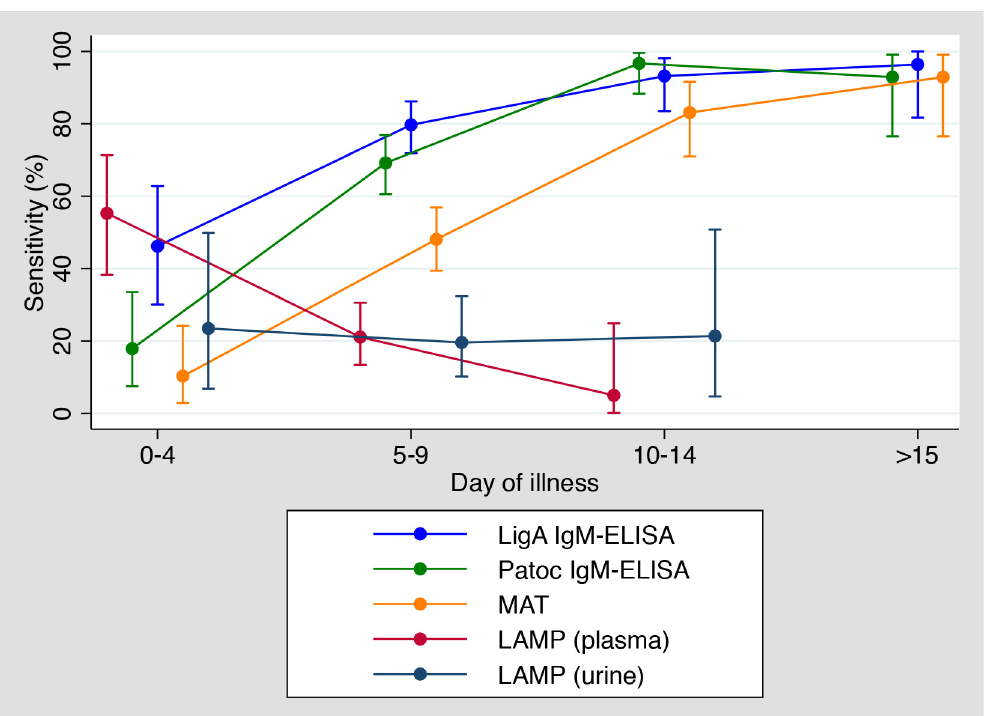
Fig 3. Comparison of sensitivity of diagnostic examination and day of illness among laboratory confirmed cases (N = 153). This figure included pair serum results of MAT and LigA / Patoc-based IgM ELISA. 11 plasma samples and 12 urine samples were not included in this analysis due to a lack of information. Vertical bars indicate 95% confidence